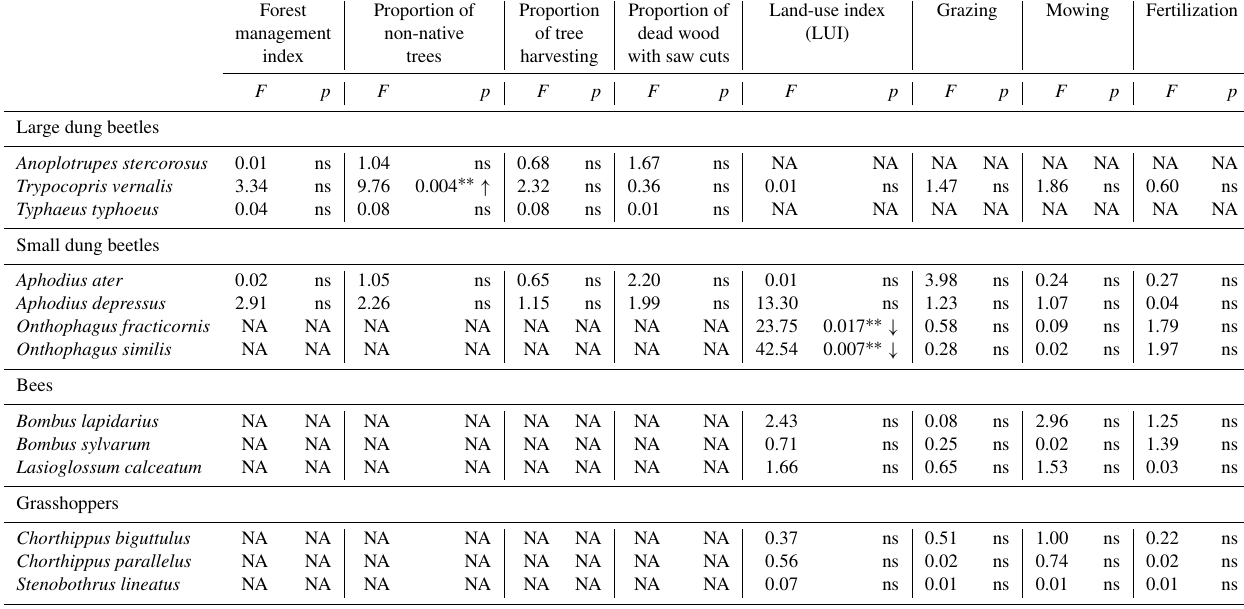
Table 3. Effects of land-use components in forests and grasslands on the within-plot variation expressed as coefficient of variation of total body length in large and small dung beetles, bees, and grasshoppers. Forest Proportion of Proportion Proportion of Land-use index Grazing Mowing Fertilization management non-native of tree dead wood trees harvesting with saw cuts